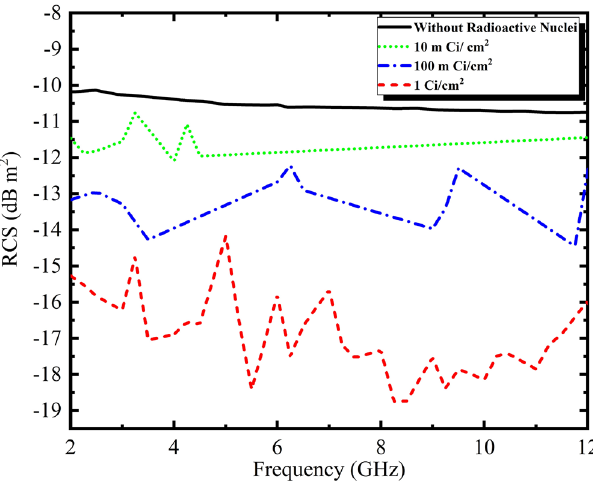
Figure 8. RCS results obtained from simulation of a conductive cylinder with a radius of 10 cm with coating of radioactive nuclei of amersium at different